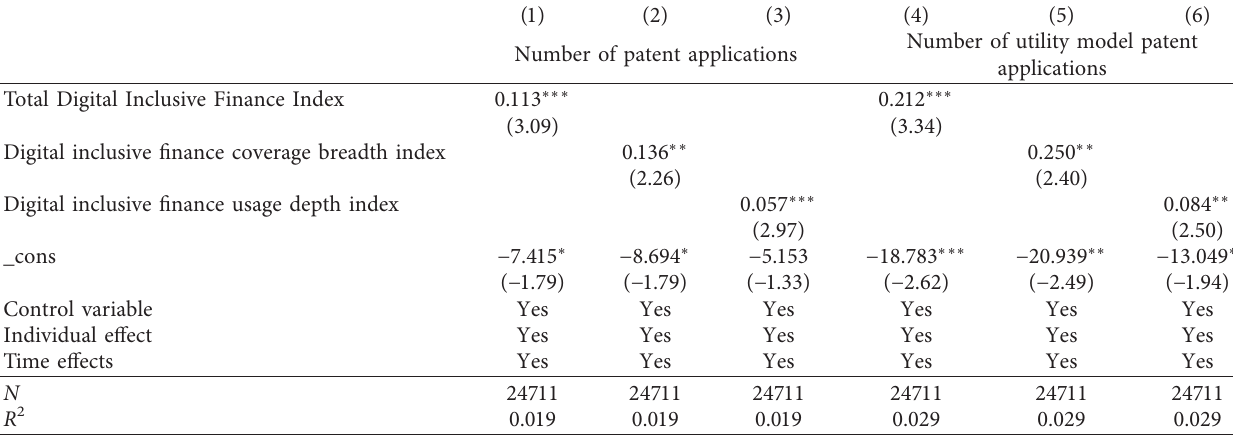
Table 1: Baseline regression